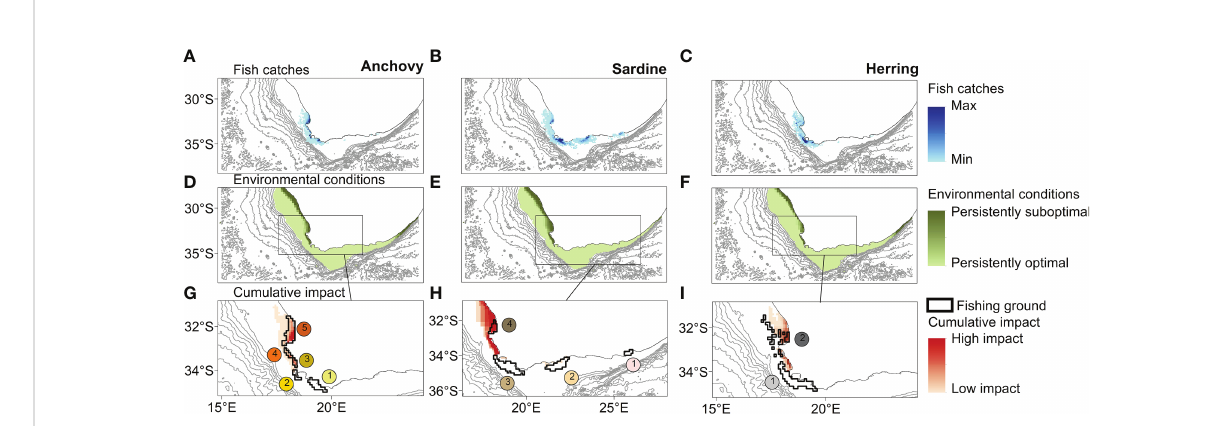
FIGURE 5 Spatially explicit information on catches of anchovy, sardine and herring (A-C) was combined with our spatial assessment on the persistency of optimal environmental conditions for the three species during the 2003-2018 period (D-F) to obtain a proxy for the cumulative impact of